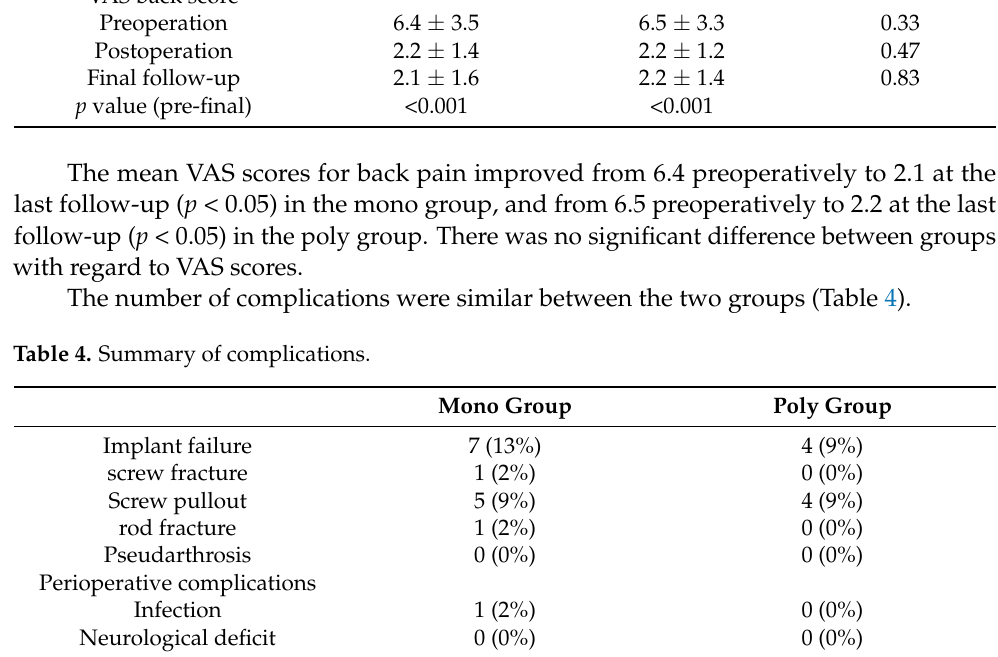
Mono Group Poly